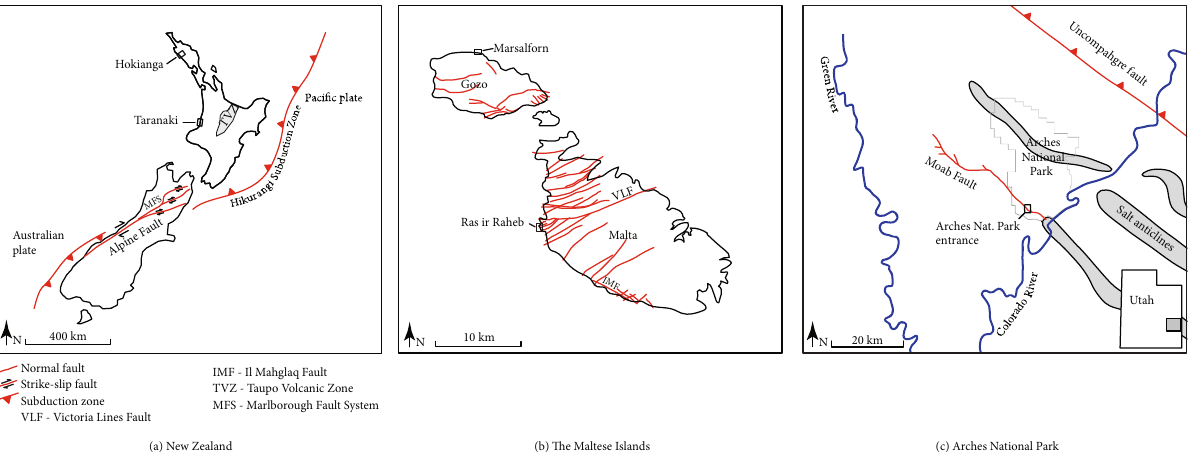
Figure 1: (a) Overview map of New Zealand, showing the fi eld areas at Hokianga and the Taranaki coast on the North Island (after Sporli and Rowland, 2007). (b) Overview map of the Maltese Islands, showing the location of the fi eld areas at Ras ir Raheb and Marsalforn (after [20, 79, 80]). (c) Overview map of the area of Arches National Park in SW Utah, USA, showing the fi eld location by the entrance of Arches National Park (after Doelling, 1985;